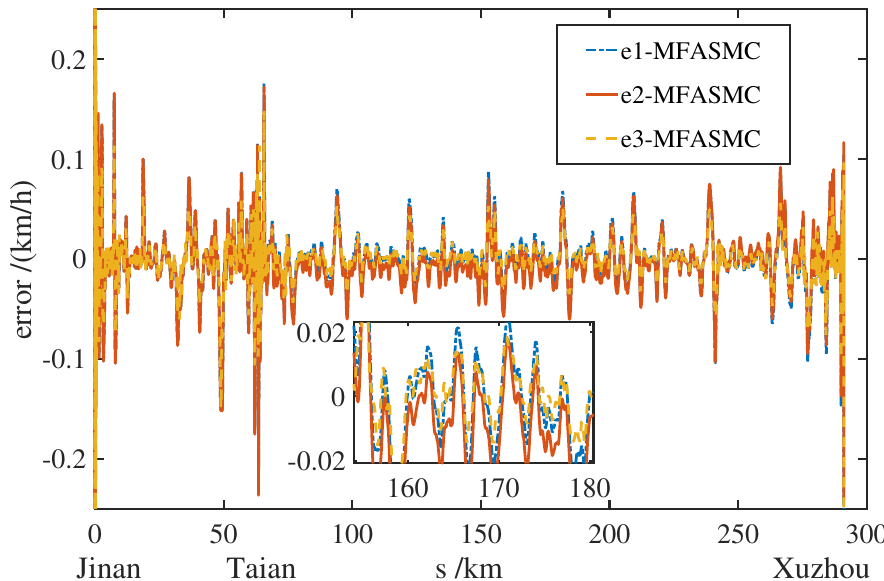
Figure 6. The speed error distribution of each power unit of MFASMC.